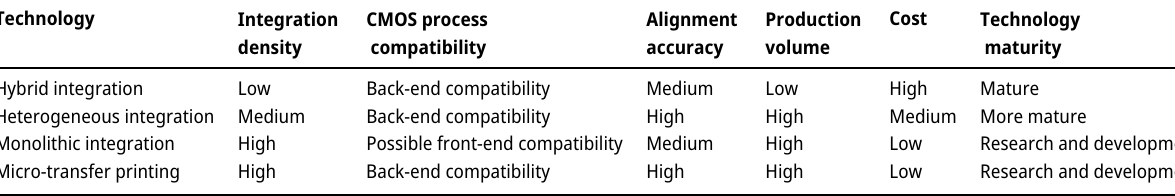
Table 1: Comparison of different integration methods.